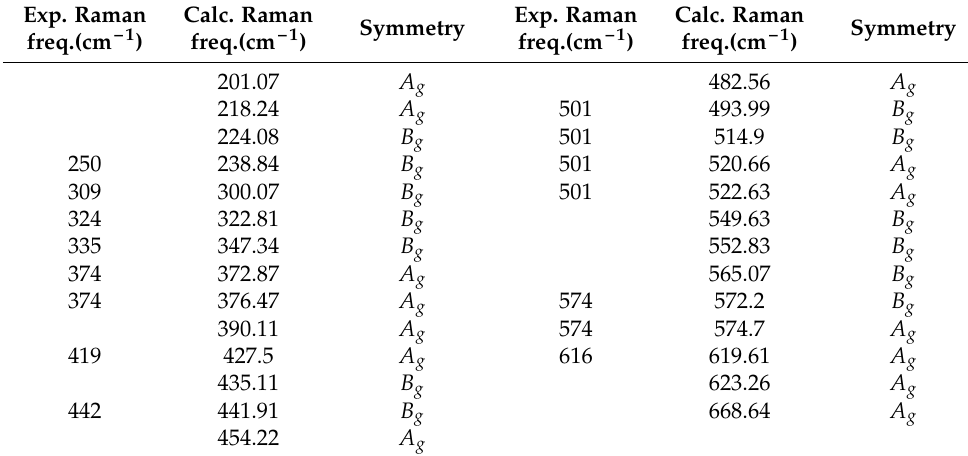
Table 3. Experimental and calculated Raman modes for the Li 2 MnO 3 crystal determined by DFPT